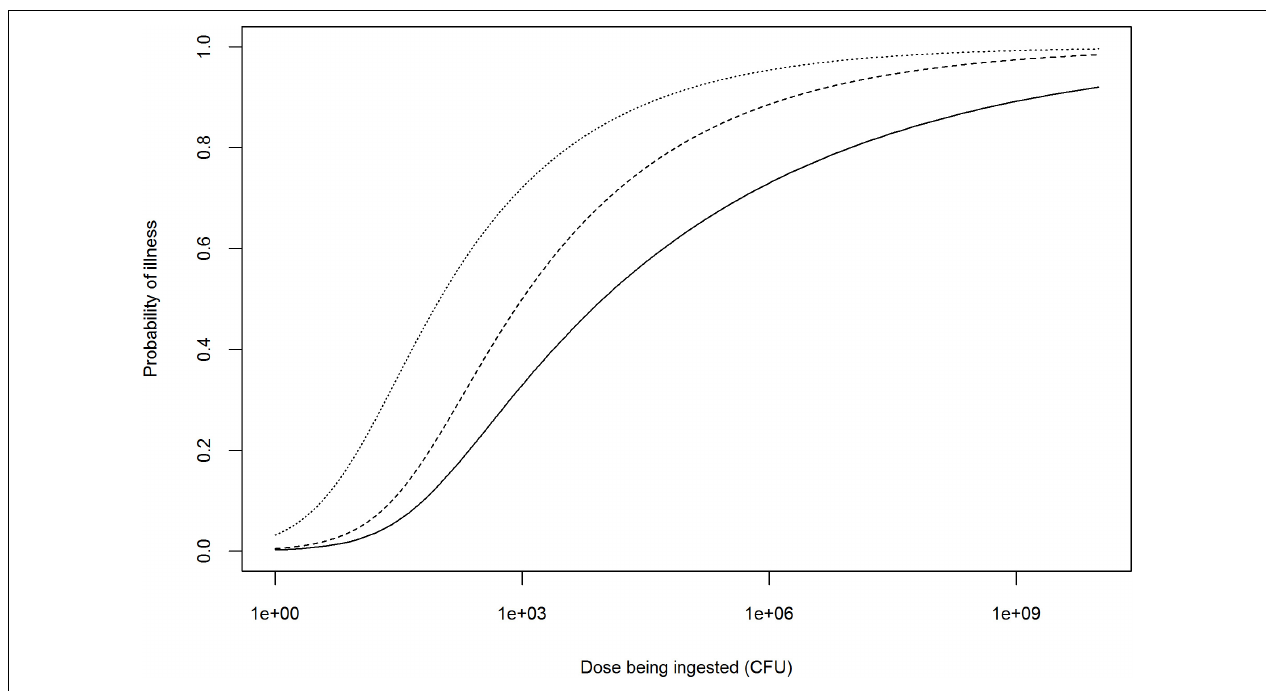
FIGURE 2 | Illustration of possible adjustments to the dose–response relationship of an antimicrobial-resistant Salmonella spp. strain based on information provided by WGS profiling. Solid line represents the dose–response curve of a generic Salmonella spp. (FAO/WHO, 2002); dashed line: dose–response after theoretical adjustment for high pathogenicity; dotted line: dose–response after theoretical adjustment for high pathogenicity and prior antimicrobial use in human